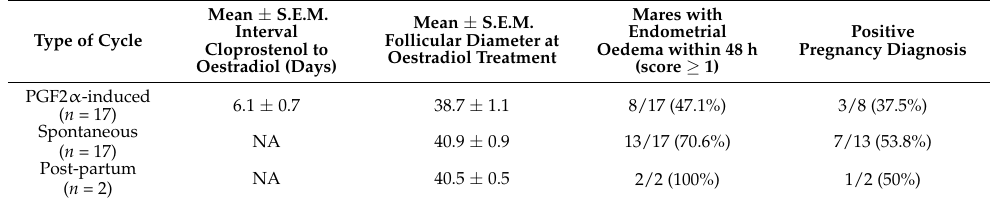
Table 2. Reproductive parameters of mares from Experiment 3 treated with 3 mg oestradiol benzoate due to lack of endometrial oedema despite of having a large follicle and no CL. Mean ± S.E.M. Type of Cycle